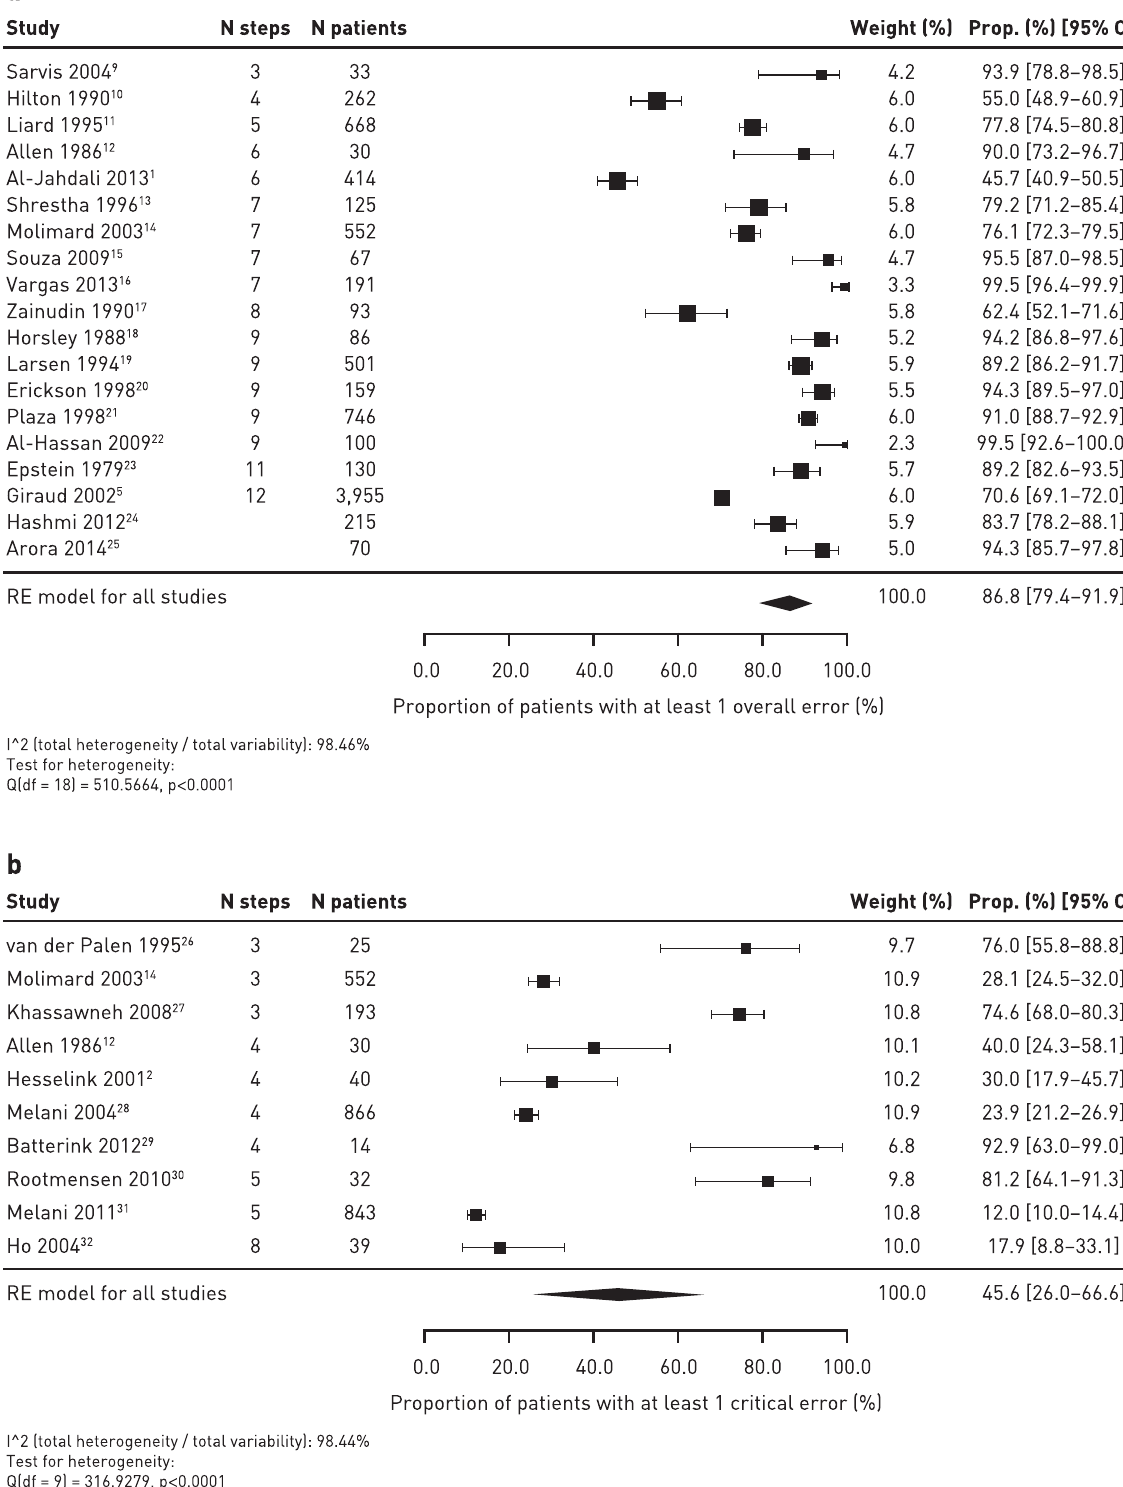
Fig. 2 Meta-analysis of the overall error rate frequency ( a ) and critical error rate frequency ( b ) for MDIs in prospective/cross-sectional